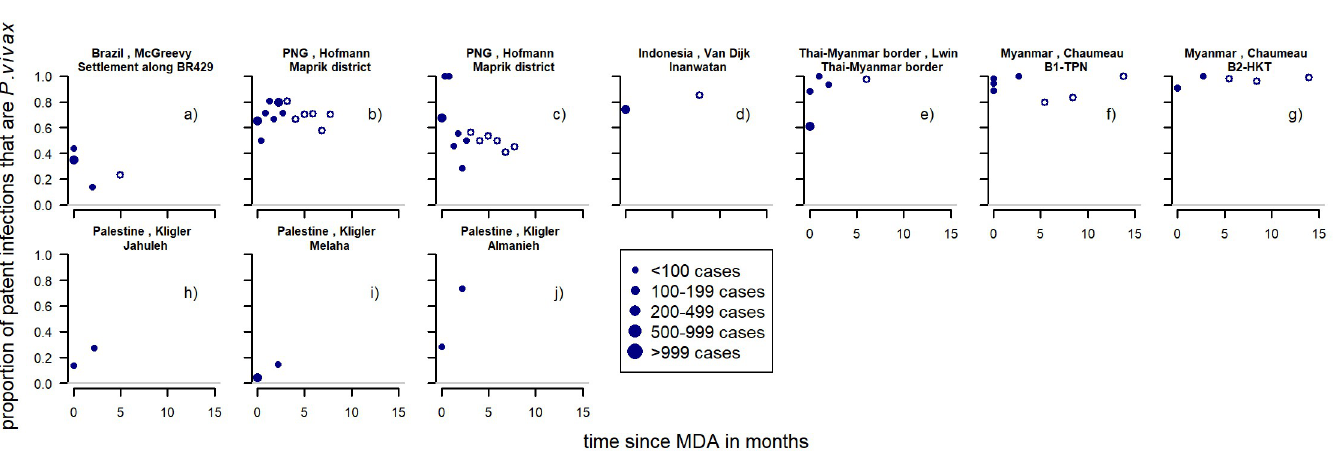
Fig 6. Proportion of patent infections that are P. vivax by time since MDA. Unfilled dots: more than 3 months after mass drug administration. Dot size depending on number of infections found Pre-intervention points as described in Methods (definition of variables: time since implementation).